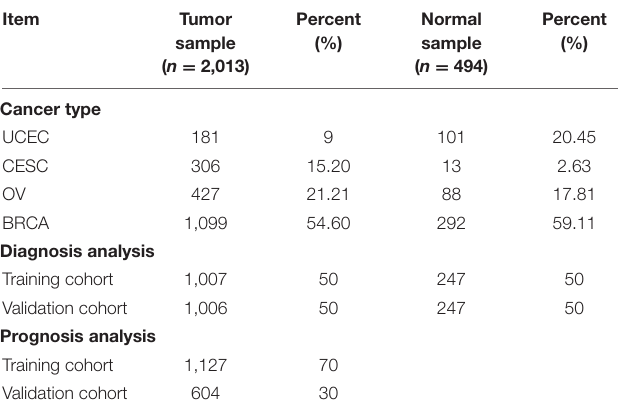
TABLE 1 | Samples’ basic